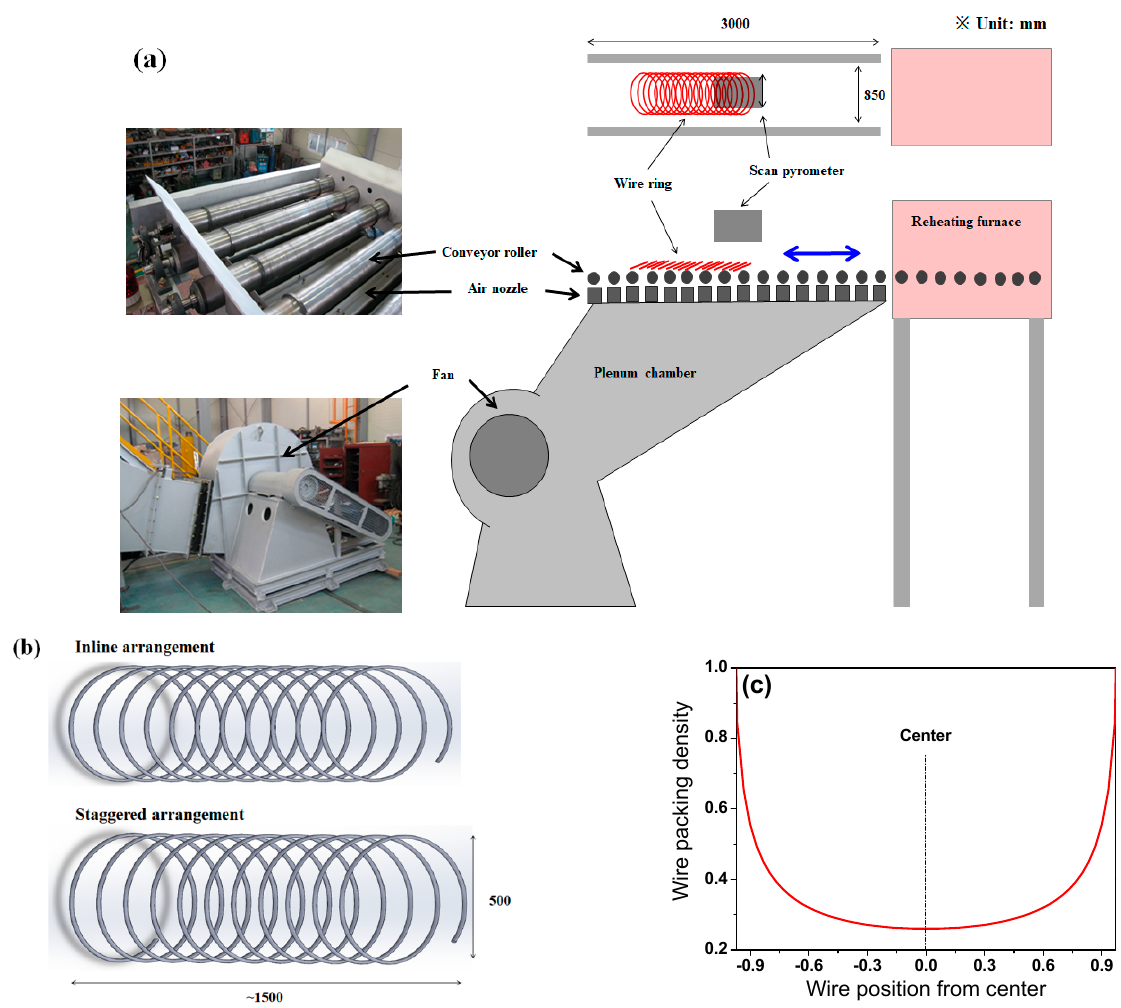
Figure 5. ( a ) Photograph and schematic of the cooling simulator, ( b ) two types of wire ring configurations, and ( c ) calculated wire packing density of the specimen used in this test. Table 1. Chemical compositions of SWRS82B steel (wt.%).